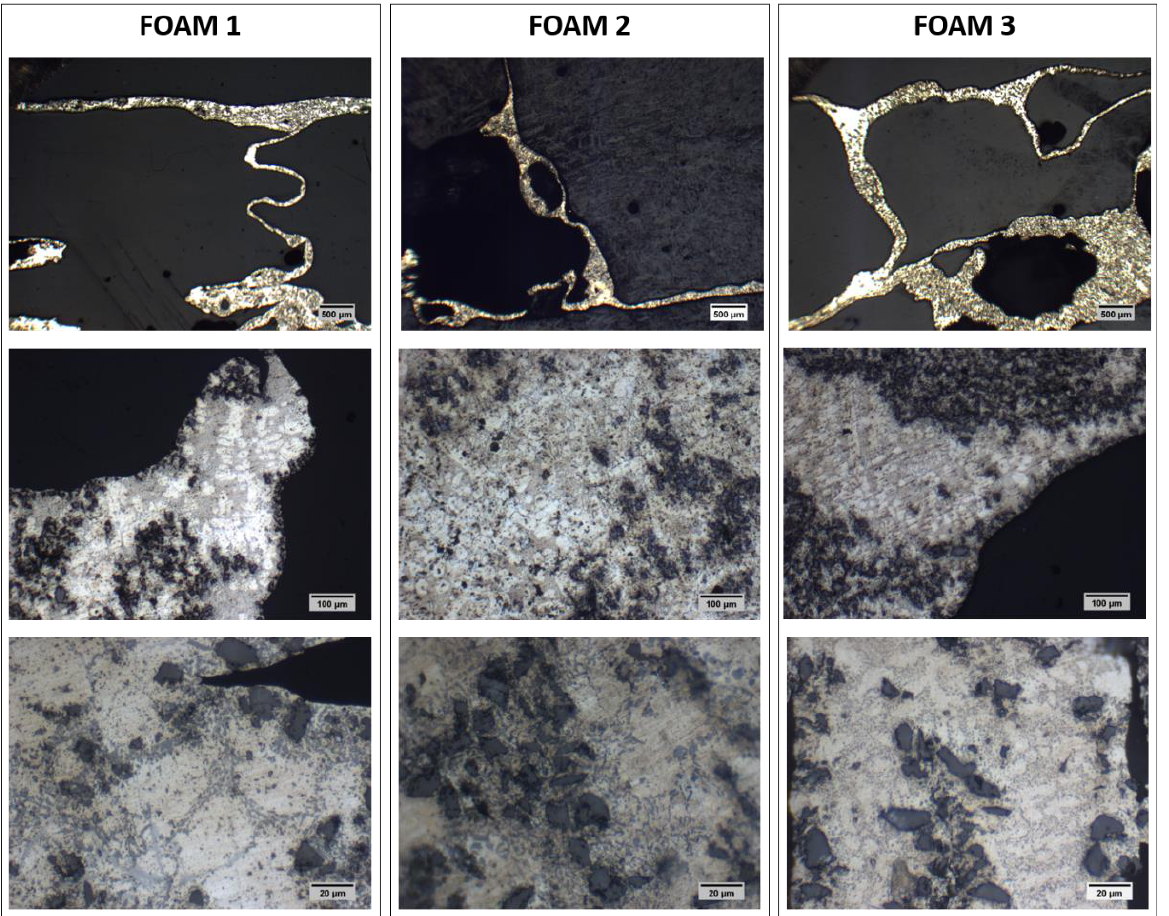
Figure 3. Optical microscope images of the foams cross-sections at different magnifications (20 × first row, 100 × second row and 500 × third